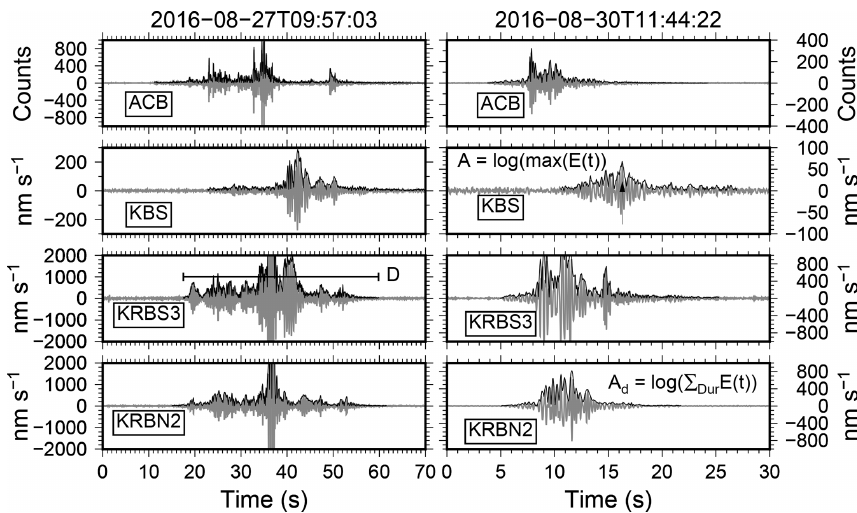
Figure 2. Examples of hydroacoustic (ACB) and seismic (KBS, KRBN2, KRBS3) signals of two calving events. Waveforms bandpass- filtered between 2 and 12Hz are shown in gray. Black curves are signal envelopes ( E(t) ) used to compute the event features: signal duration ( D ), logarithm of envelope amplitude integrated over event duration ( A d ), and logarithm of maximum envelope amplitude ( A ). Note that for hydroacoustic data the raw digitizer output is processed